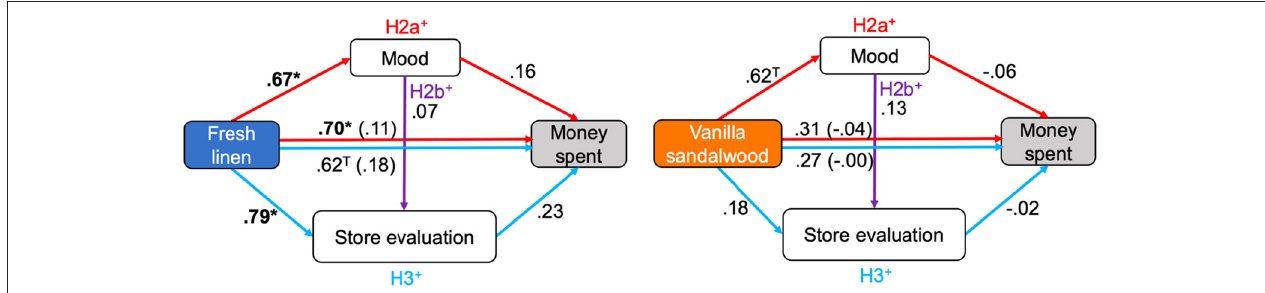
FIGURE 4 | Conceptual model with standardized regression weights and significance indicated . Comparisons include fresh linen (left) and vanilla sandalwood (right) vs. regular store odor. * P < 0.05.